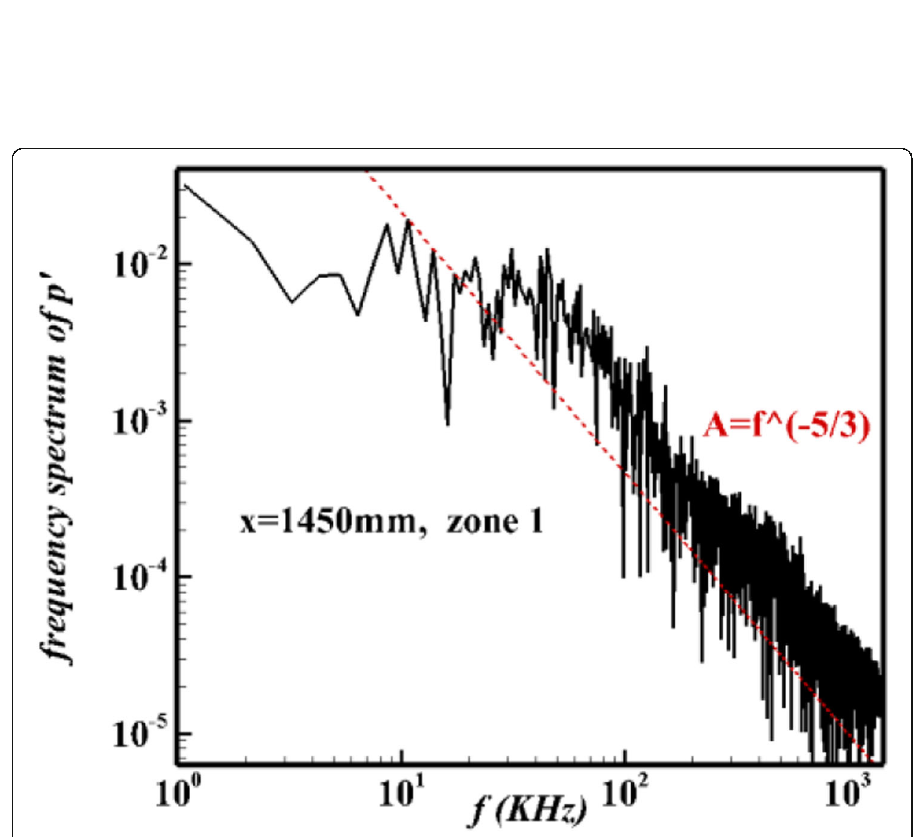
Fig. 17 Spectra of pressure of zone 1 at x = 1450